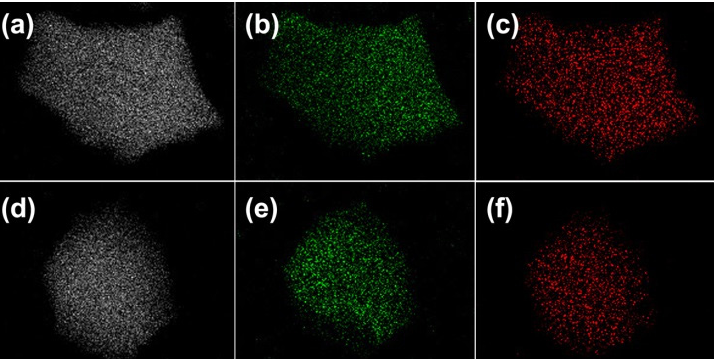
Figure 4. Elemental analysis mapping showing the distribution of Al ( a , d ), O ( b , e ), and Zr ( c , f ) for two different regions of the sample OMZA-6.